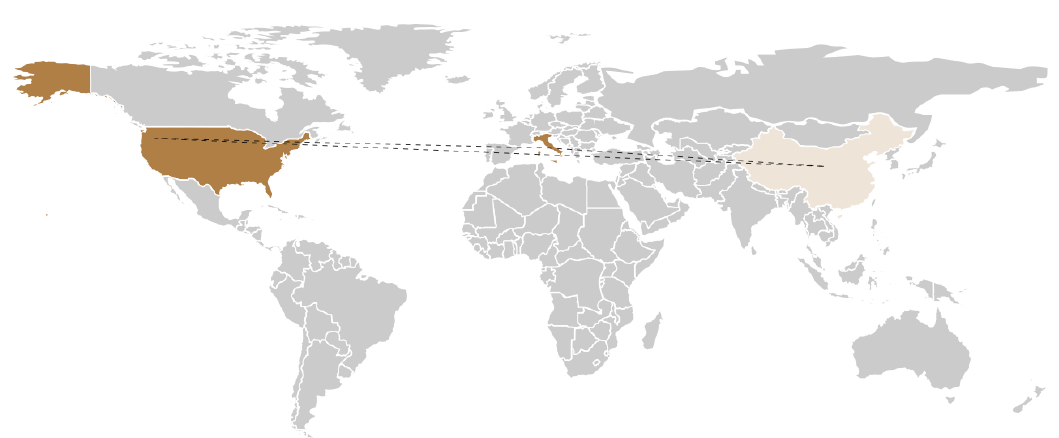
Figure 3. First flow of infection of COVID-19 from Asia to Europe to America and then to